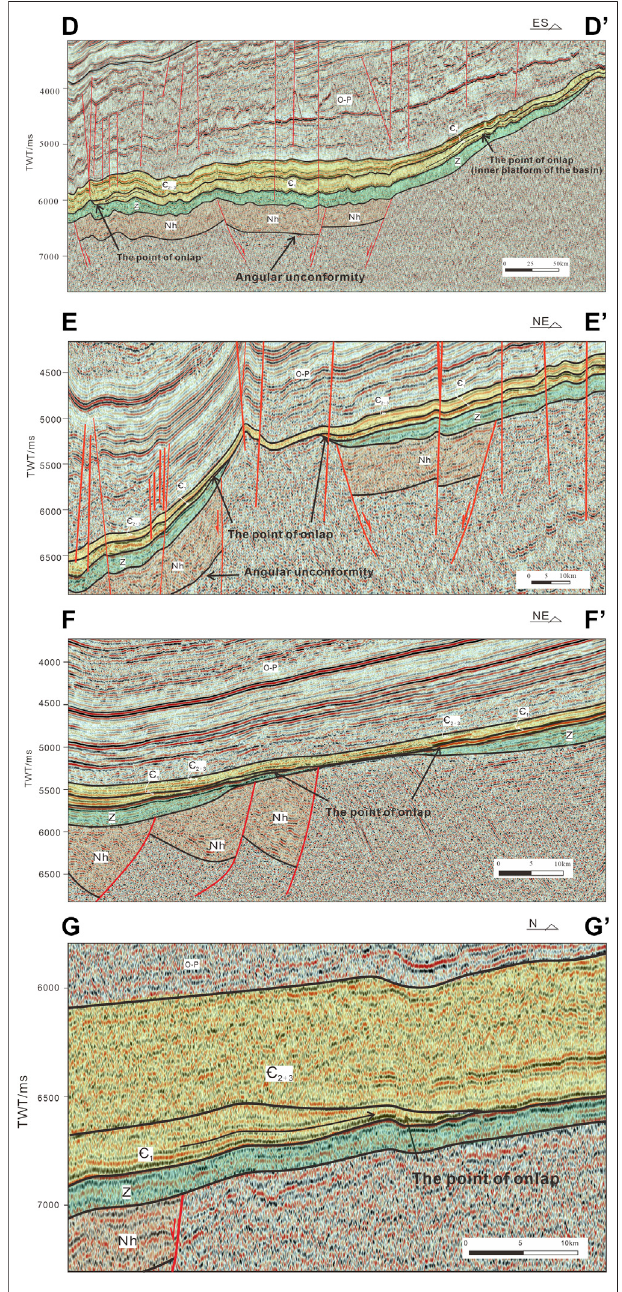
FIGURE 5 | Onlap unconformities on seismic pro fi les in the Tarim Basin (see Figure 3 for locations). O – P: Ordovician to Permian sequence.